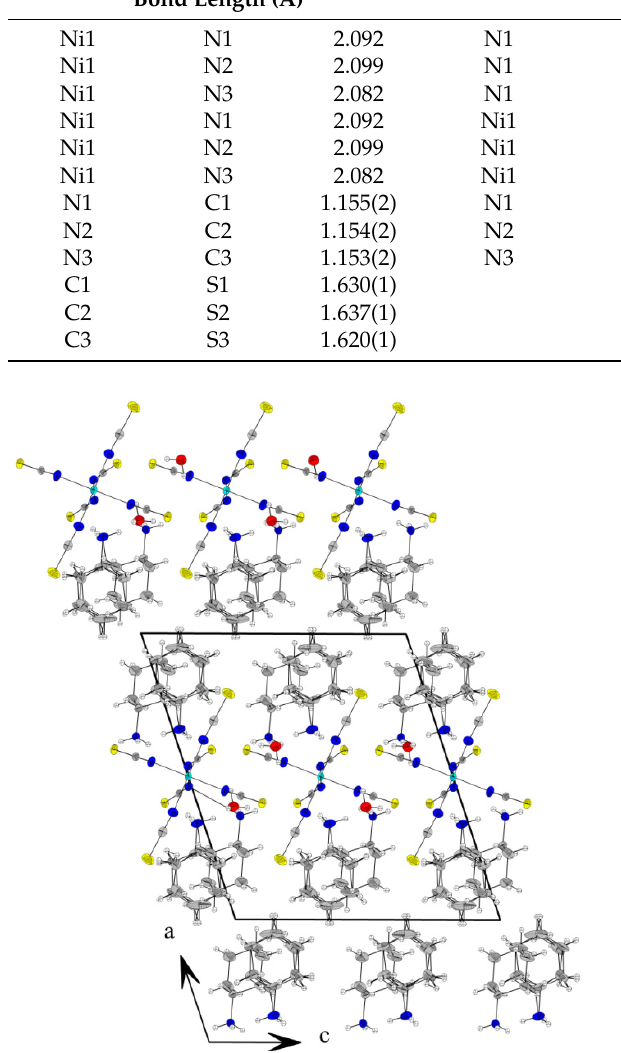
Figure 4. Projection view (C 6 H 11 NH 3 ) 4 [Ni(NCS) 6 ].2H 2 O along the b-axis. Table 4. List of possible hydrogen bonds at 120K for (C 6 H 11 NH 3 ) 4 [Ni(NCS) 6 ].2H 2 O.